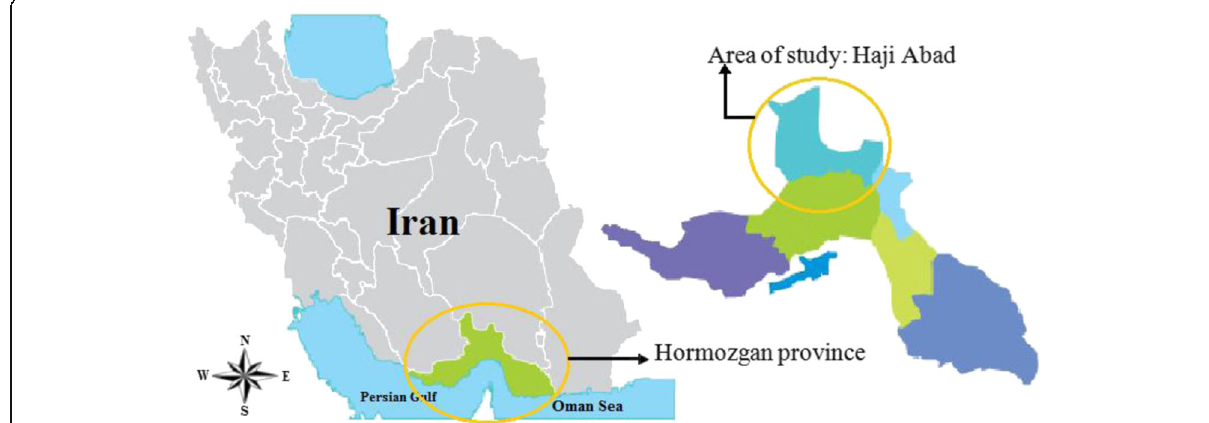
Fig. 1 Location of the study area in Hormozgan province, south